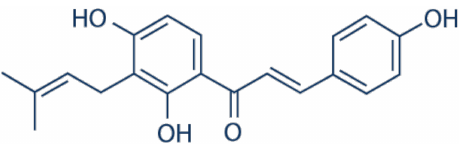
Figure 16. The chemical structure of isobavachalcone.